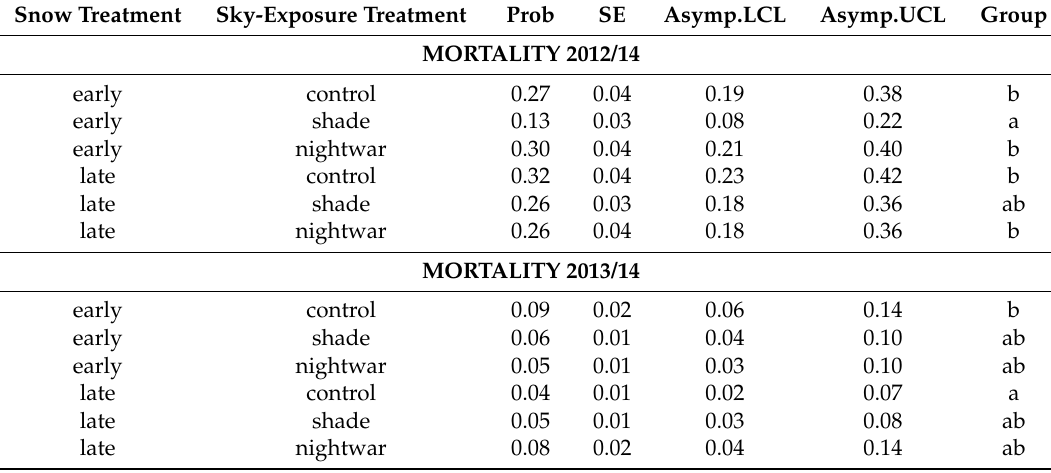
Table 3. Model estimates (Prob = probability of mortality) and Tukey-adjusted pair-wise comparisons (snow:sky exposure), averaged over species, in the GLMs assessing the effect of snowmelt timing and sky-exposure treatments on final mortality of tree seedlings at the alpine treeline after two (2012/2014) or one (2013/2014) seasons in the field. SE = Standard error, Asymp.LCL and Asymp.UCL = asymptotic lower and upper control limits. Groups indicate significantly different treatment combinations. Snow Treatment Sky-Exposure Treatment Prob SE